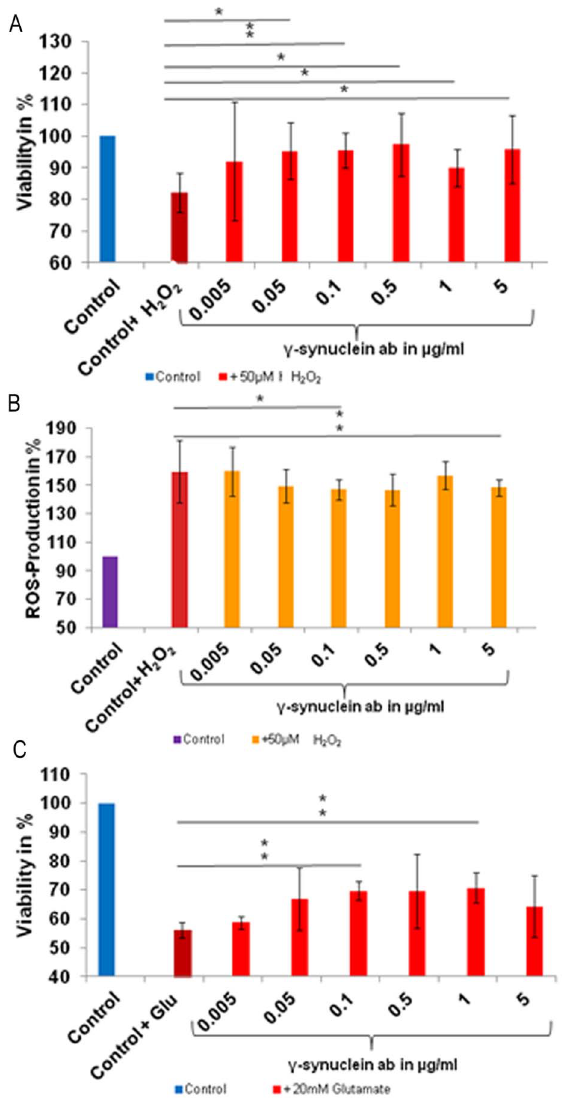
Figure 1. Viability and ROS-level of c -synuclein ab treated and stressed RGC-5. RGC-5 were preincubated with different c -synuclein ab concentrations and additionally stressed with 20 mM glutamate for 24 h and 50 m M H 2 O 2 for 1 h. Cell viability as well as ROS-level were determined using crystal violet and DCFH-DA (*=p , 0.05; **p , 0.01) A : Increased significant and high significant cell viability were measured after the cells were preincubated with 0.05–5 m g/ml c -synuclein abs and additionally stressed with H 2 O 2 . B : Significant and high significant decreased ROS production was measured, when the cells were preincubated with 0.1 and 5 m g/ml c -synuclein abs. C : Increased cell viability in a range of 0.05–5 m g/ml c -synuclein abs were obtained after the cells were stressed with glutamate, whereby the results of 0.1 and 1 m g/ml are high significant.